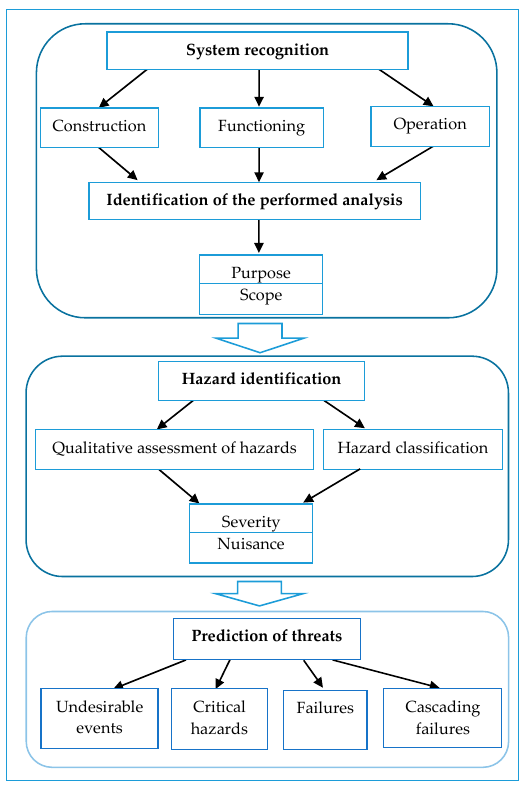
Figure 1. Steps in the analysis and assessment of the safety of a gas-supply system.